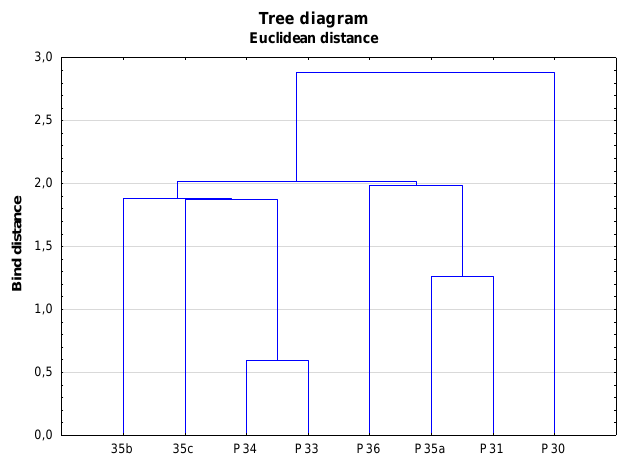
Figure 6. Tree diagram for supply chains of function execution.